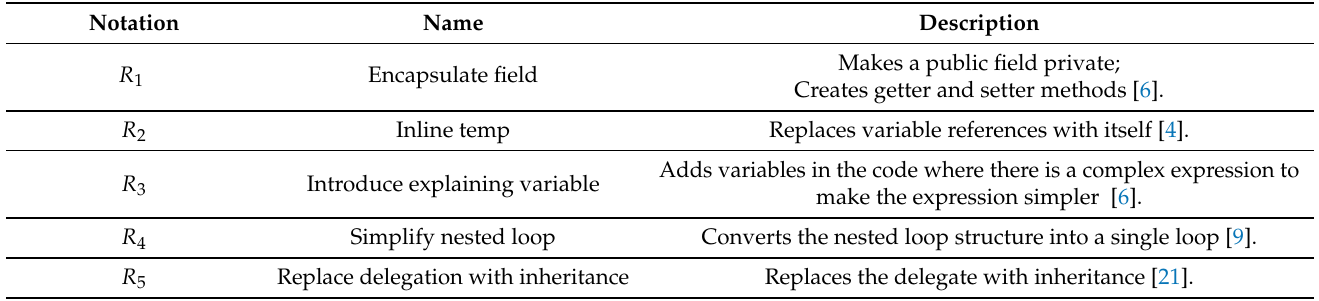
Table 1. Refactoring